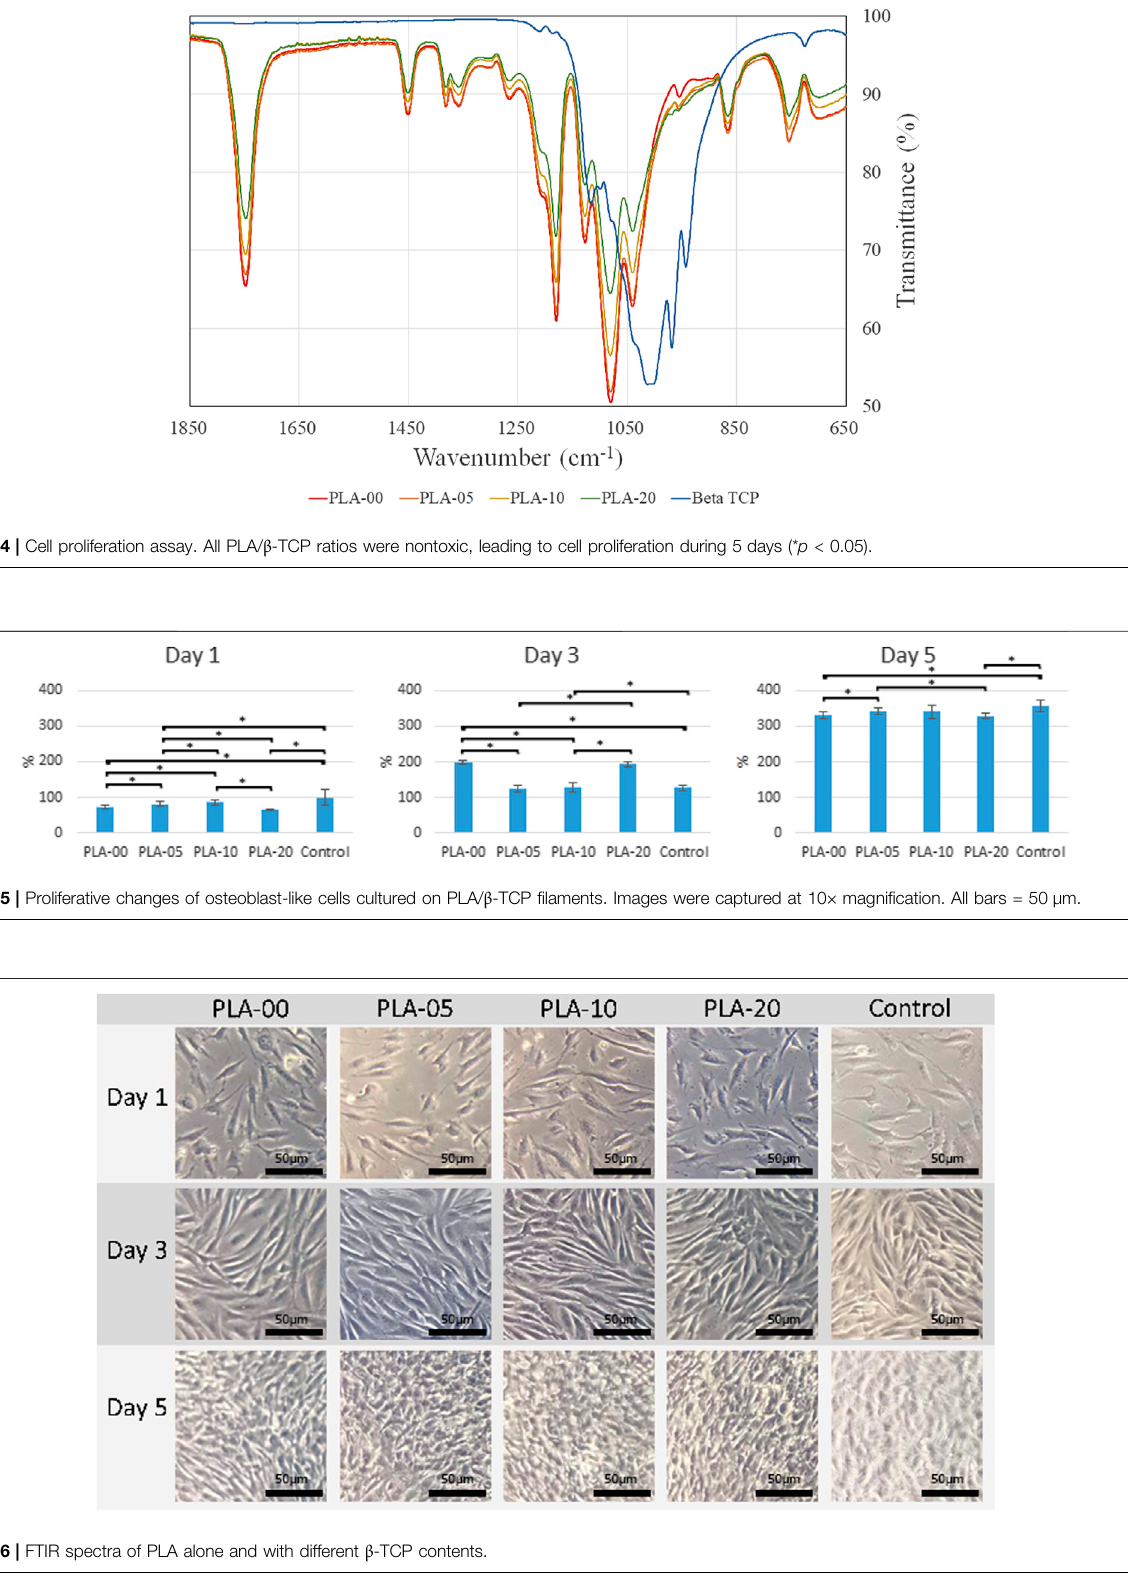
Frontiers in Materials |